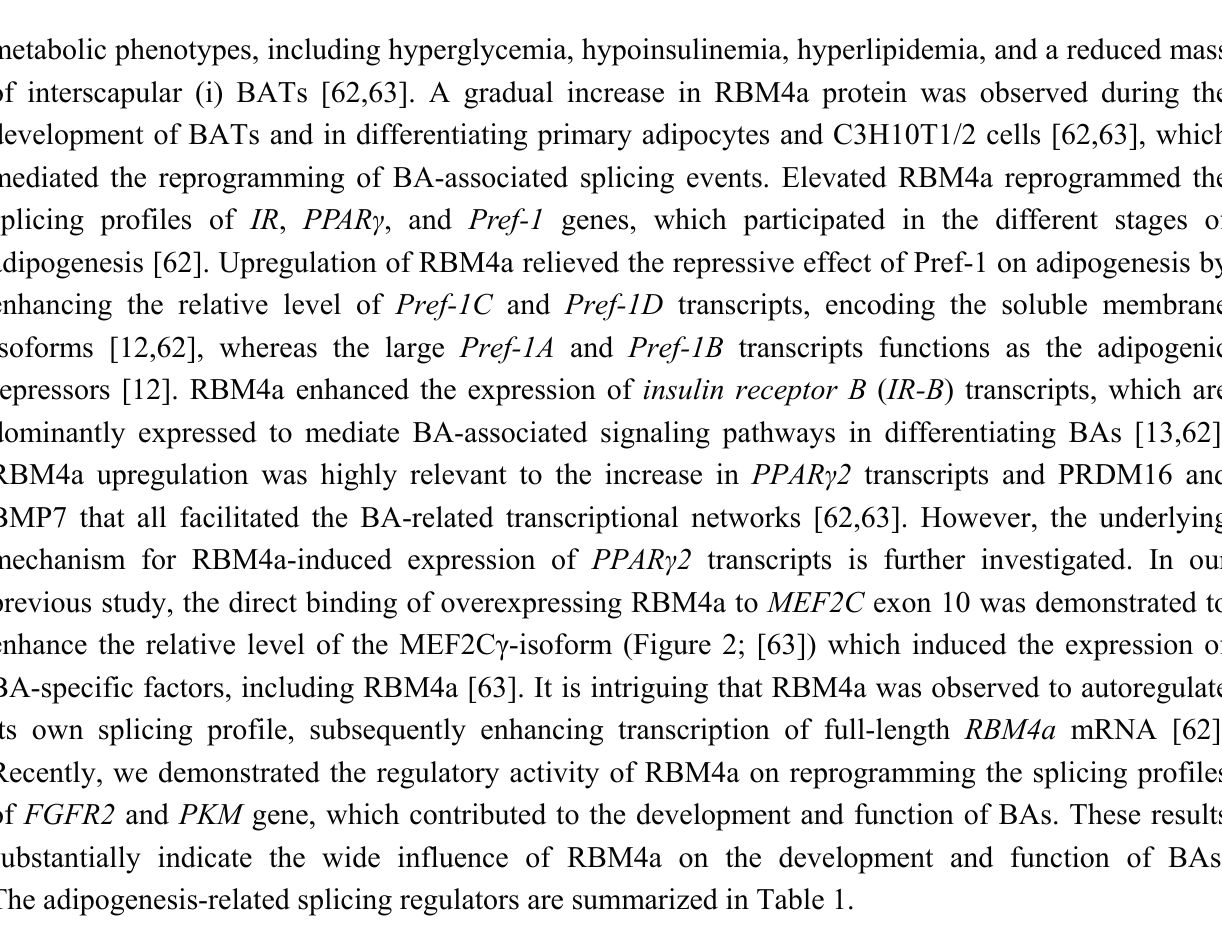
Table 1. Distinct splicing factors modulate a set of adipogenesis-related AS events. Splicing Factor or